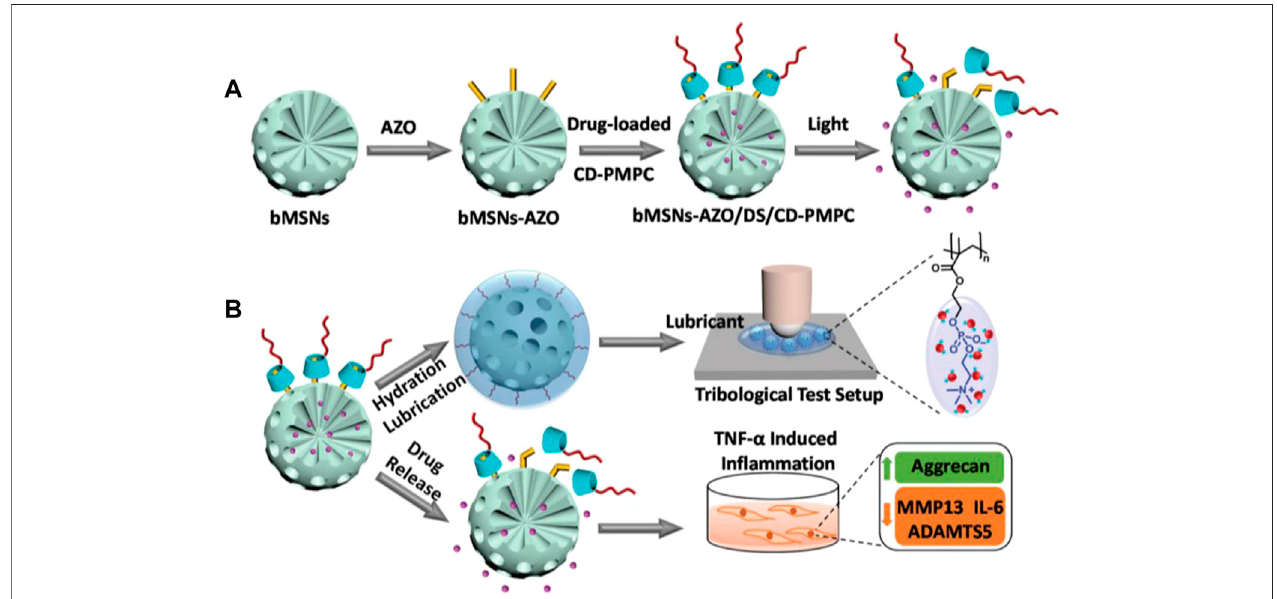
FIGURE 5 | Drawing of the visible light-responsive dual-functional nanosystem with drug delivery and lubrication enhancement for OA. (A) Synthesis of bMSNs nanoparticles and the corresponding modi fi cation process. (B) Mechanism of lubrication enhancement and anti-in fl ammatory properties. Reproduced with permission (Zhao et al., 2021). Copyright 2021, Royal Society of Chemistry.